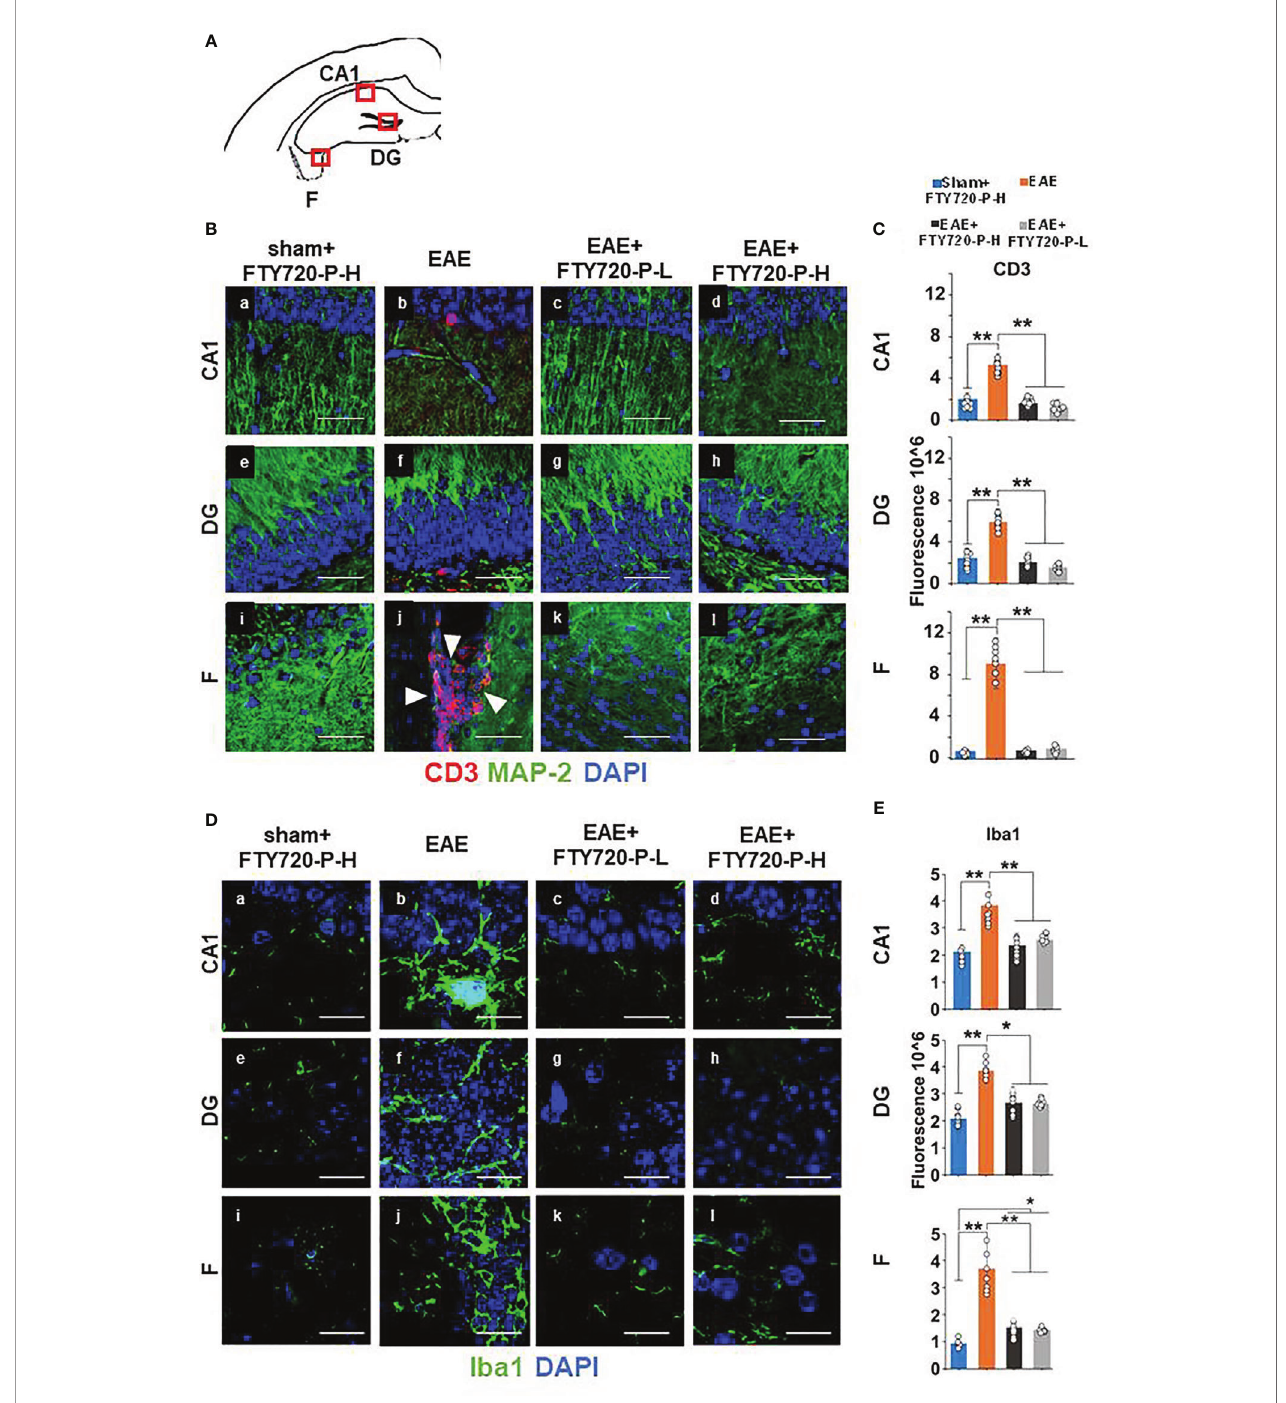
FIGURE 3 | Anti-in fl ammatory effect of FTY720 on the hippocampus. Following EAE induction, mice received FTY720 via drinking water at low dose (EAE+FTY720- L; 0.3mg/kg) or high dose (EAE+FTY720-H; 0.7mg/kg), with n = 8 mice/group. Controls consisted of EAE, sham+FTY720-H (shown) and sham+FTY720-L (not shown) groups. Half of each cohort was used to quantify drug effects by immunochemistry in regions shown in (A) (red boxes): CA1, dentate gyrus (DG) and fi mbrium (F); (Ba – l) show anti-CD3 (red) + anti-MAP-2 (green) and (Da – l), anti Iba1 (green) immunostaining. Nuclei were stained with DAPI. (C, E) show the quanti fi cation of CD3, or Iba1 in each region, with sham+FTY720-H (dark blue), EAE (orange), EAE+FTY720-H (dark grey) and EAE+FTY720-L (light grey) groups estimated by ImageJ using an arbitrary scale. N = 4 mice/group × 6 sections/mouse; *p < 0.05, ** p < 0.01; scale bars = 20 µm. Experiments were replicated 2 times. Data were analyzed using one-way ANOVA and shown as mean ± standard error of the mean